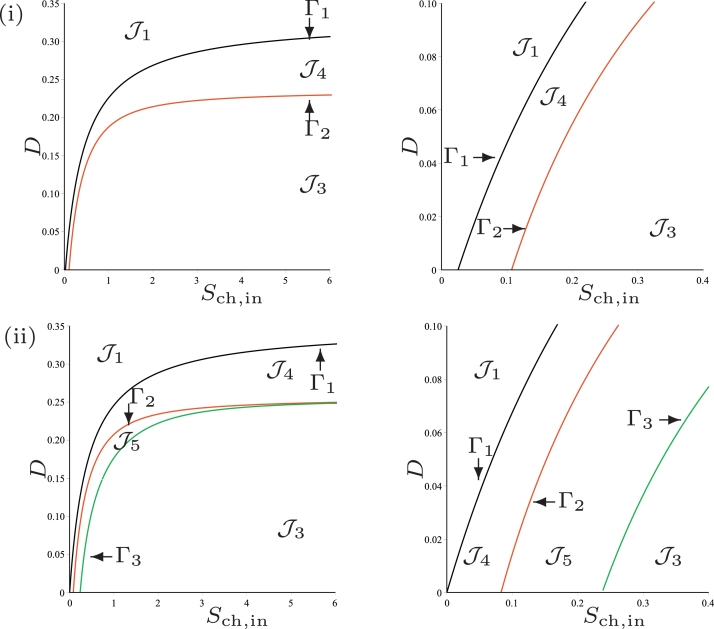
The curves Γ1 (black), Γ2 (red) and Γ3 (green) for case (b). (i) : regions of steady-state existence, with maintenance. (ii) : regions of steady-state existence and their stability, without maintenance. On the right, a magnification for 0 < D < 0.1. (For interpretation of the references to colour in this figure legend, the reader is referred to the web version of this article.)